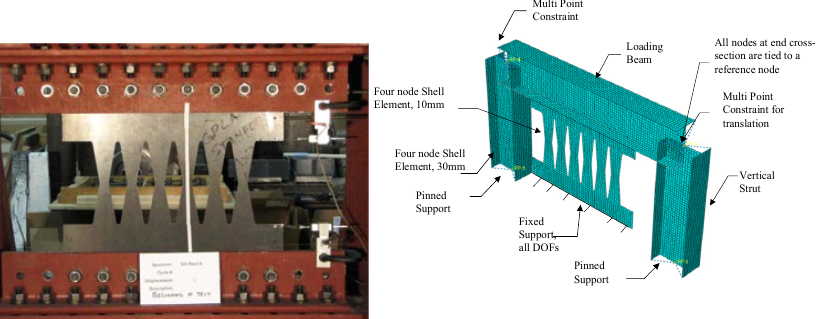
Figure 14. Specimen B10-36W done by Ma et al. [2] and the FE computational model description and details for FEM verification purposes.